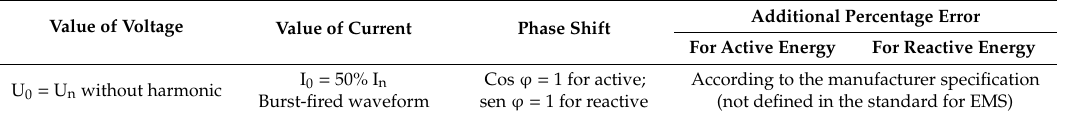
Table 8. Influence of the harmonic components in the current circuit on the EMS.